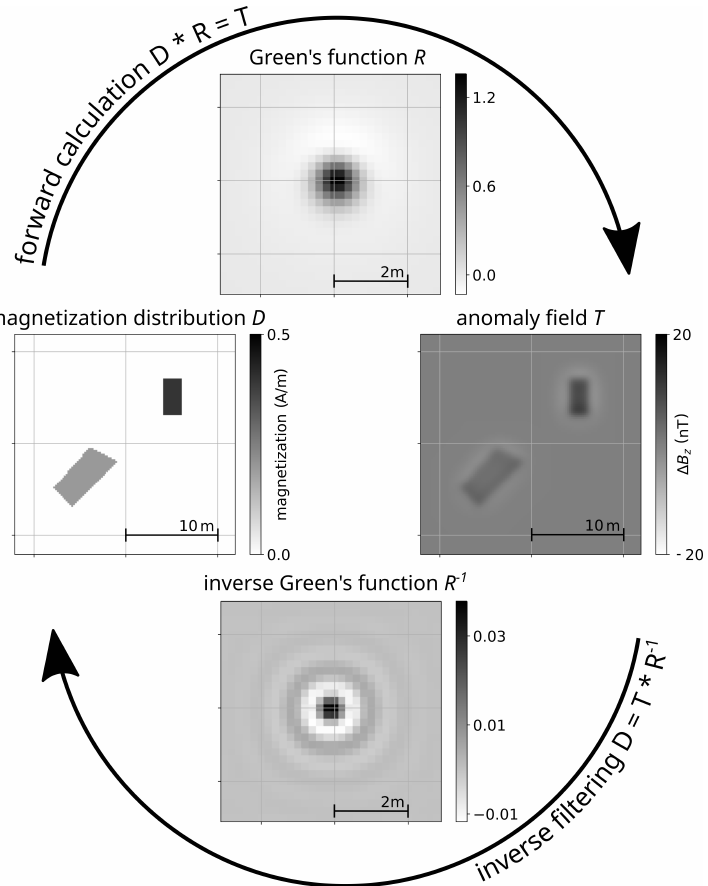
Figure 2. Illustration of methodical concept. The magnetization distribution D and the magnetic anomaly field T are related by the Green’s function R in terms of forward calculation and by the inverse of R in terms of inverse